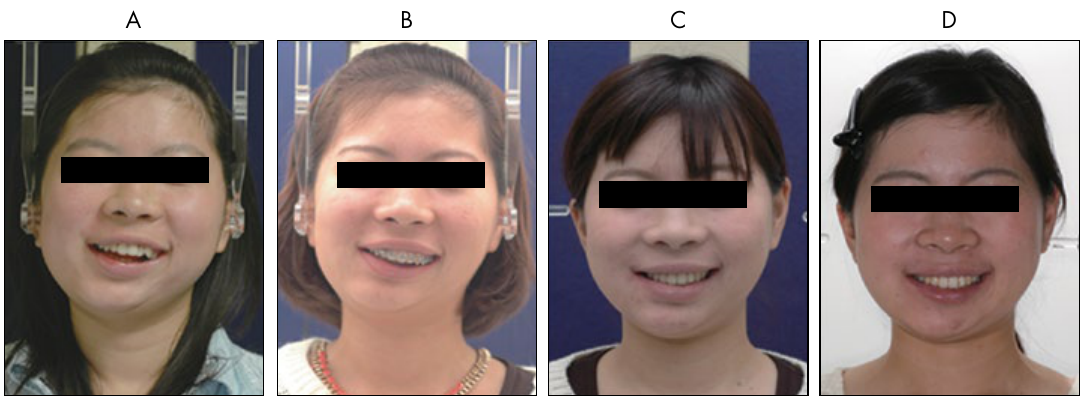
Figure 2. Facial photographs in full smile. A: pretreatment; B: pre-surgery; C: post-treatment; D: post-retention, two years and six months after surgery.